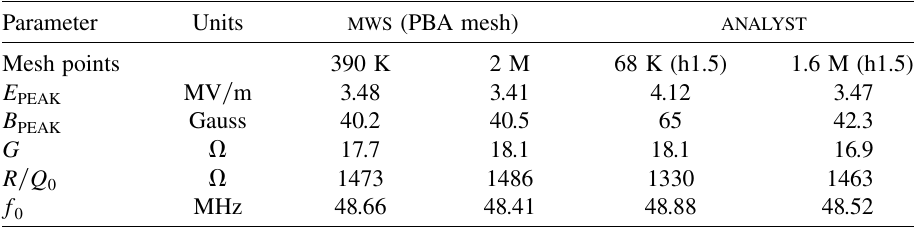
TABLE III. Comparisons of type-II cavity simulations performed with MWS and ANALYST . All (cid:1) 1 MV = m . data are given for E ACC